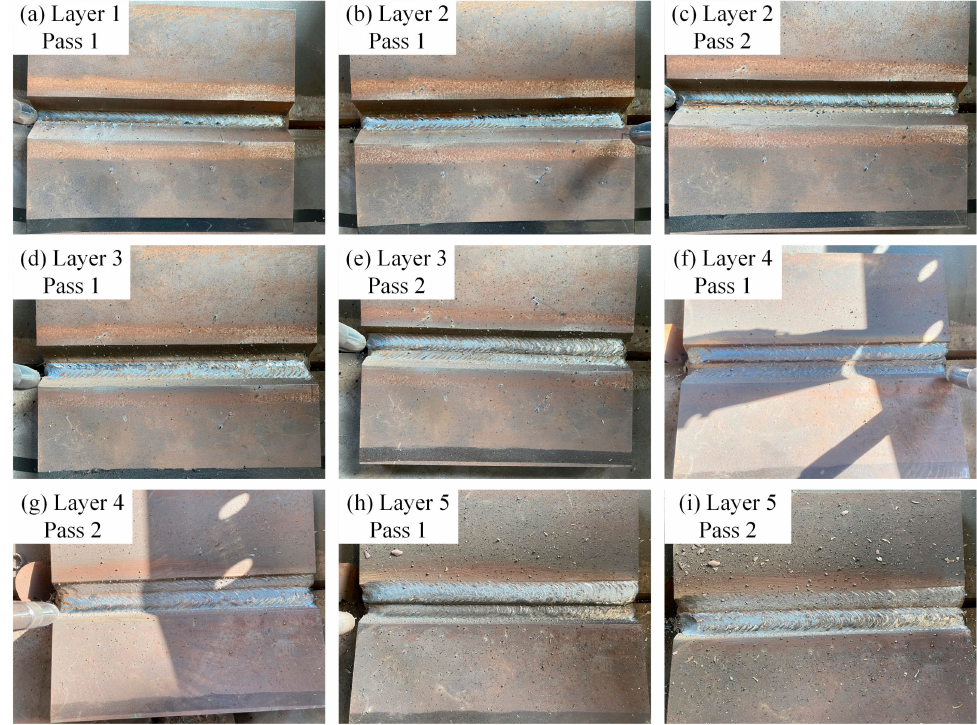
Figure 14. Actual welds of the experimental sample. ( a ) 1–1; ( b ) 2–1; ( c ) 2–2; ( d ) 3–1; ( e ) 3–2; ( f ) 4–1;